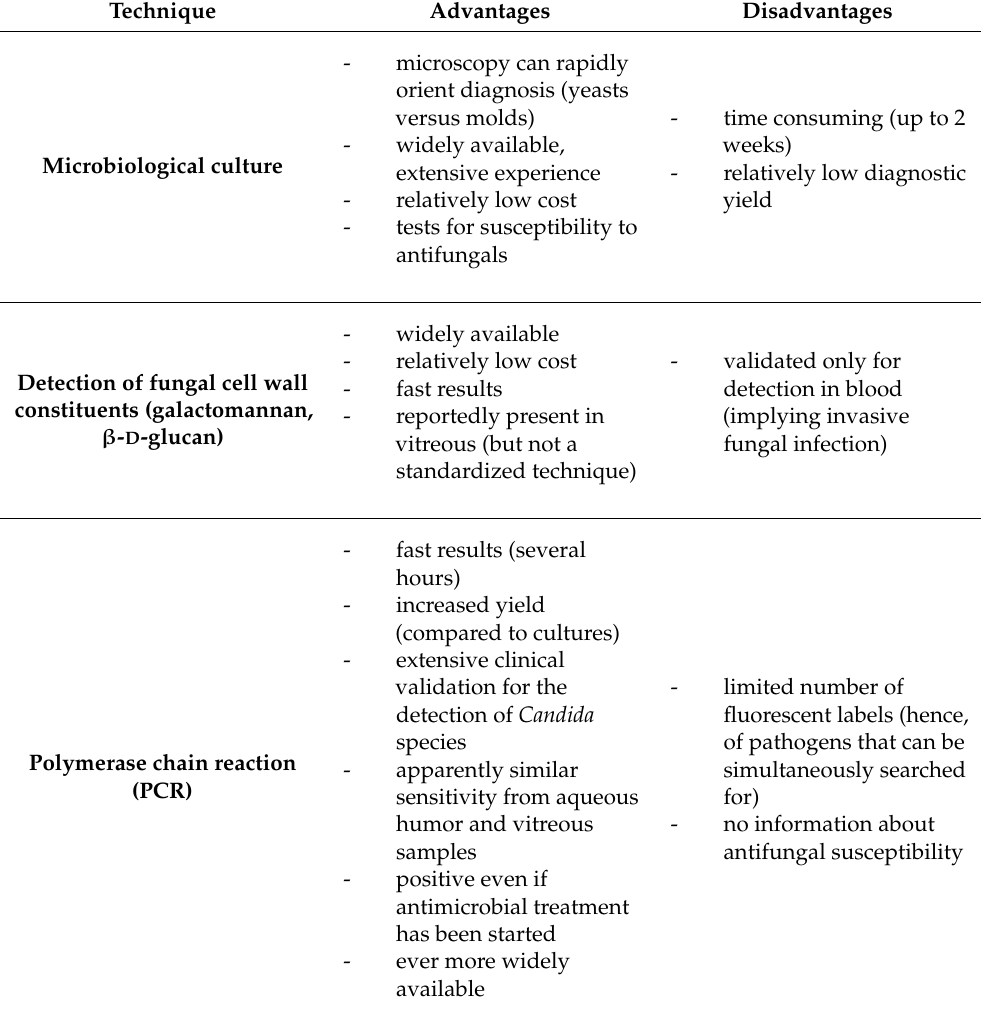
Table 2. Advantages and disadvantages of currently available diagnostic